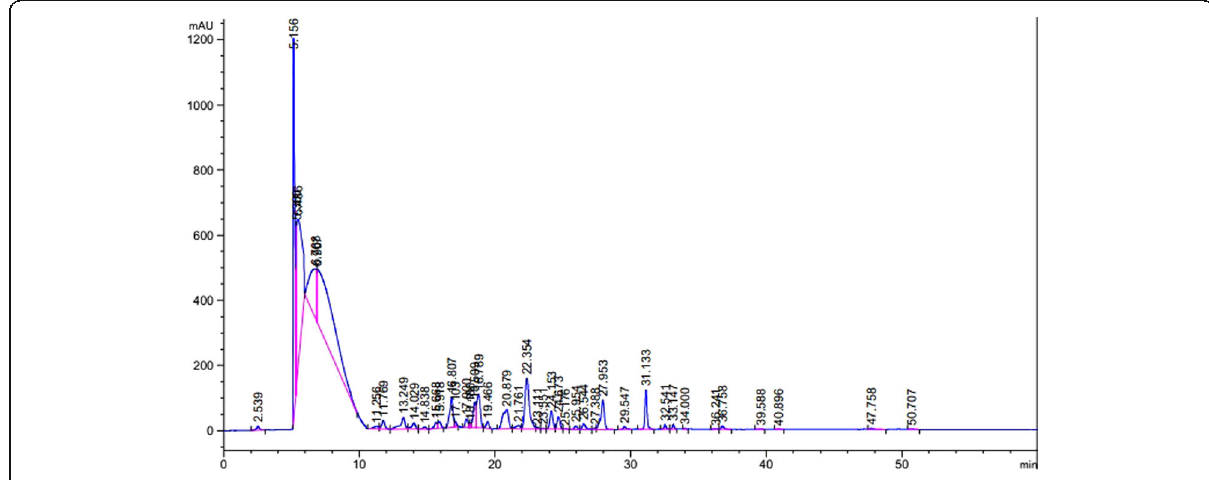
Fig. 2 HPLC-DAD chromatogram of methanolic extract of Olax